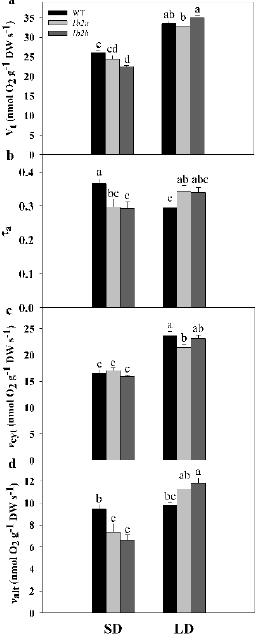
Figure 2. Respiration and electron partitioning between cytochrome and alternative pathways in leaves of wild-type (WT) and cytc mutants ( 1b2a and 1b2b ) grown in short-day (SD) and long-day (LD) photoperiods. ( a ) Total respiration (V t ), ( b ) electron partitioning to the AOX pathway ( τ a ), ( c ) COX pathway activity ( v cyt ), and ( d ) AOX pathway activity ( v alt ). Values are means ± SE of six to nine replicates. Significant differences are denoted by different letters ( p < 0.05; two-way ANOVA).